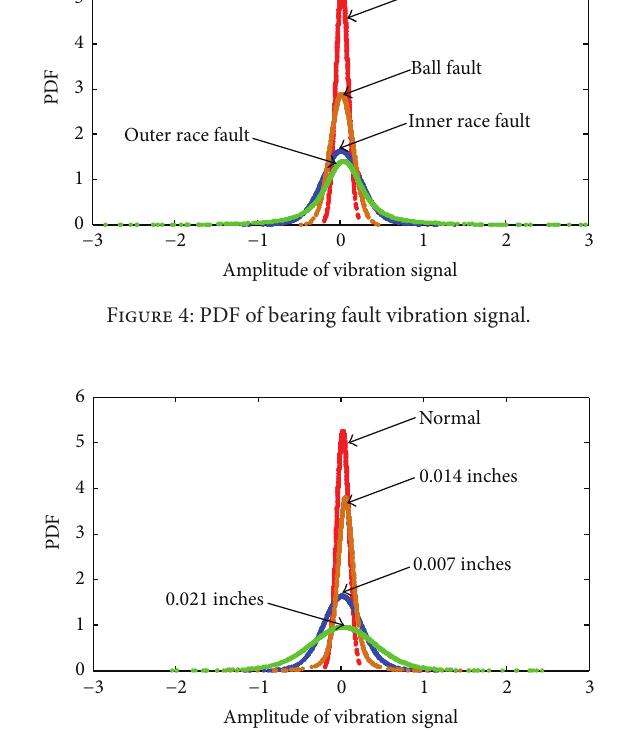
Figure 5: PDF of bearing fault vibration